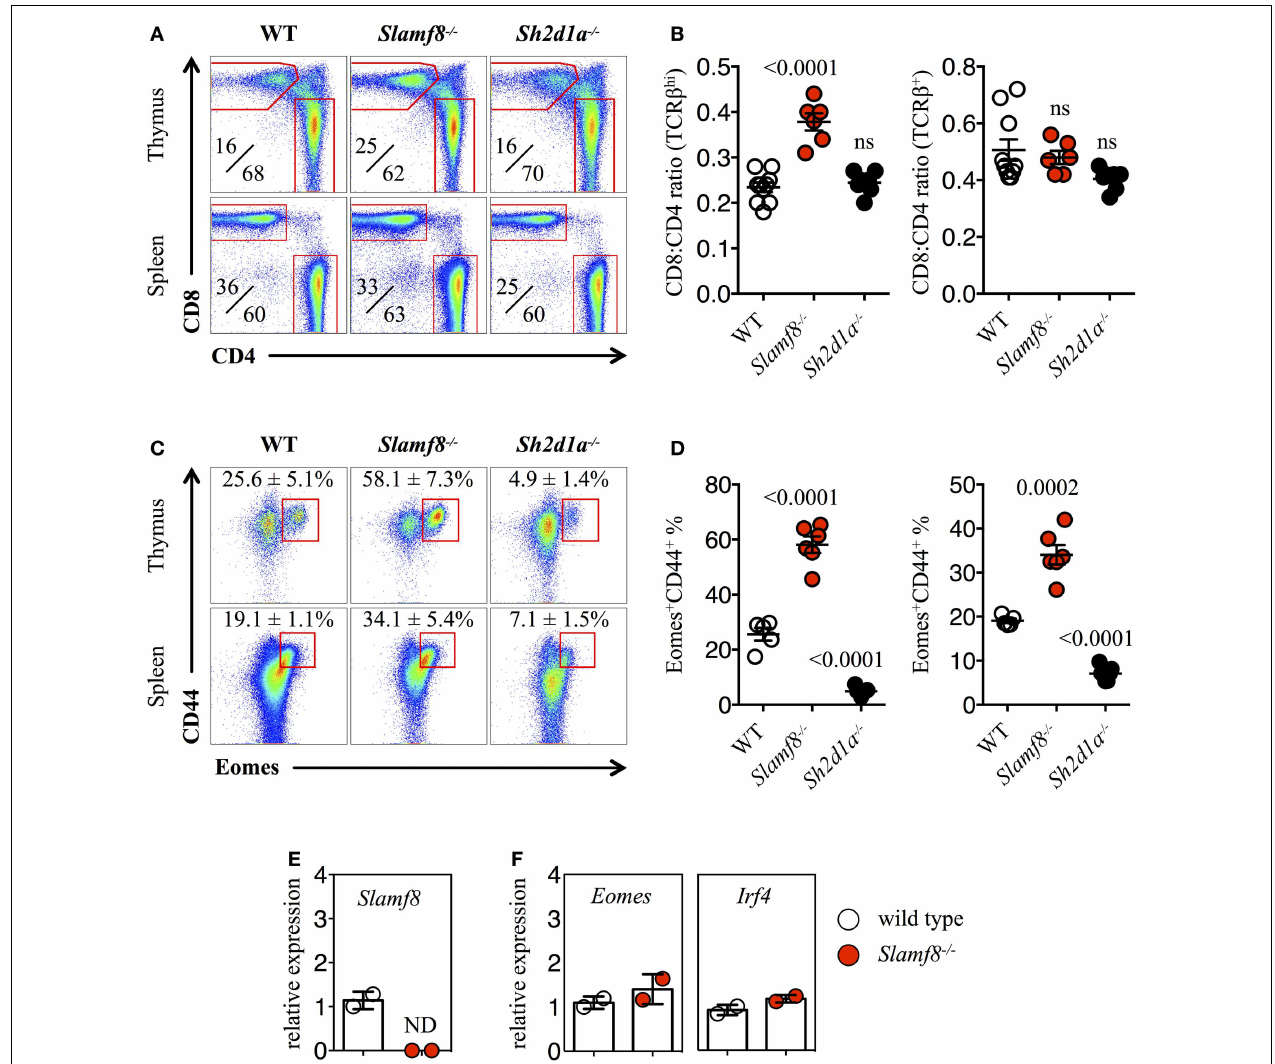
spleen ( right ) ofWT, Slamf8 − / − or Sh2d1a − / − BALB/c mice. (E) The relative mRNA expression of Slamf8 , or Eomes and Irf4 (F) was determined in total thymocytes fromWT or Slamf8 − / − BALB/c mice by real-time PCR. Results were normalized to the expression of the housekeeping gene 18S rRNA and expressed relative toWT BALB/c levels (WT = 1); ND, not detected. Numbers inside plots show the mean percentage (A) or the mean percentage ± SD (C) of the indicated population. Cumulative graphs show the results of four independent experiments, mean ± SEM.The p values were calculated by unpaired t -test between theWT group and the Slamf8 − / − or Sh2d1a − / − group. A value of p < 0.05 was considered significant; ns,